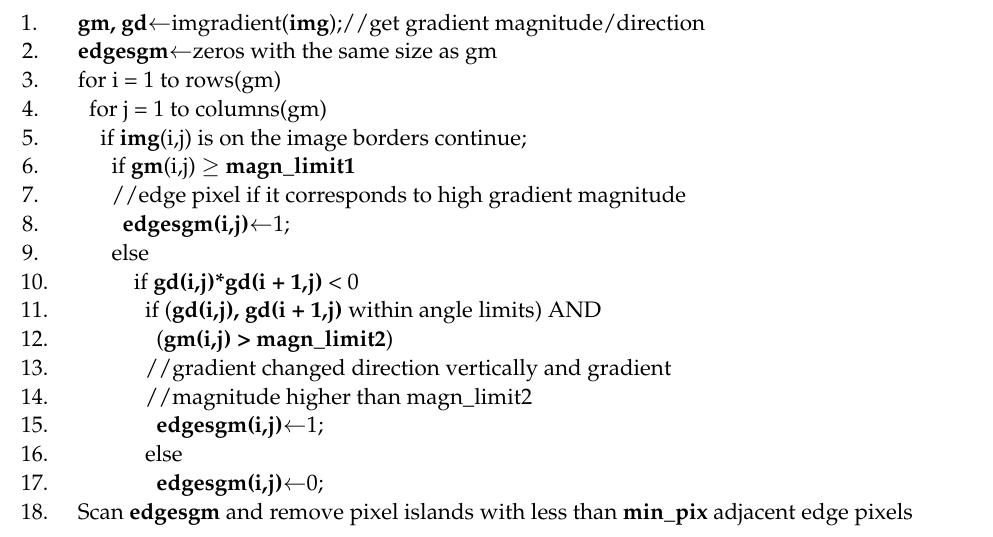
Algorithm 1 Custom edge detection